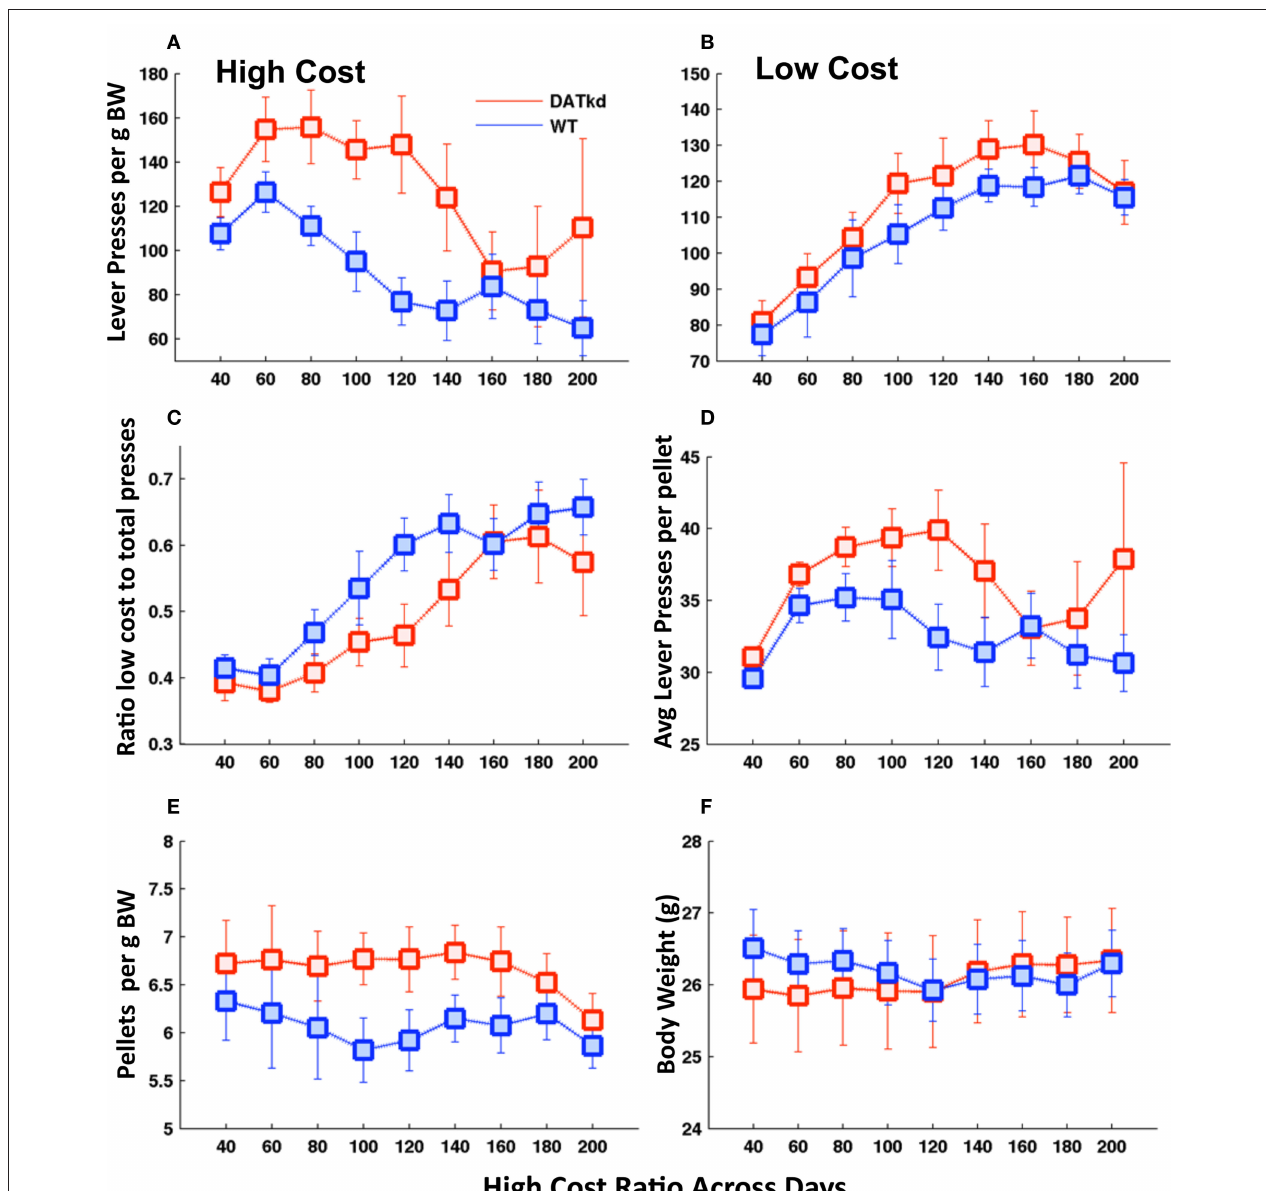
Figure 1 | Lever pressing, consumption and body weight across experimental days . Average number of lever presses (LP) per gram of body weight on the (A) expensive lever (genotype, p < 0.01) and (B) inexpensive lever (genotype, NS). (C) Ratio of lever presses on the low cost lever to total lever